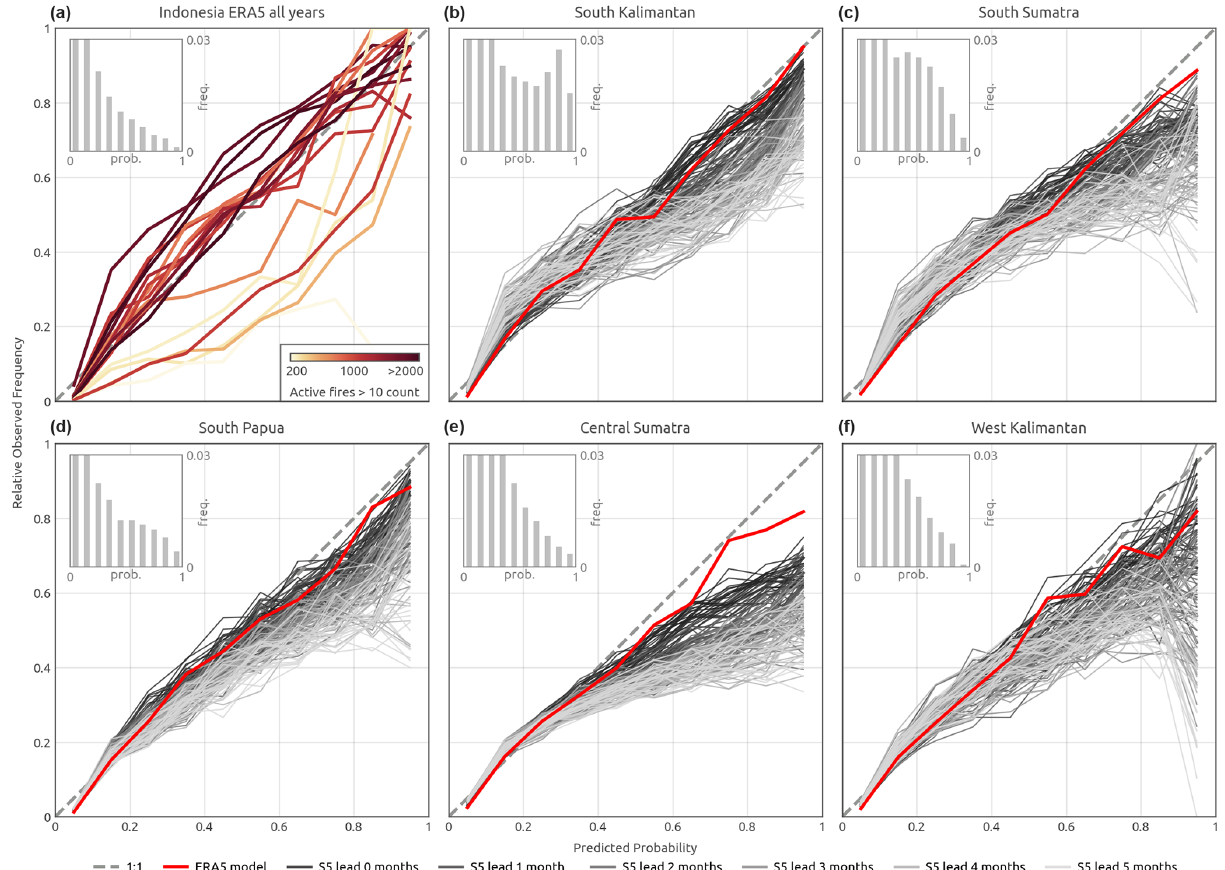
Figure 5. Same as Fig. 4 but for prediction of probability for an active-fire count of > 10